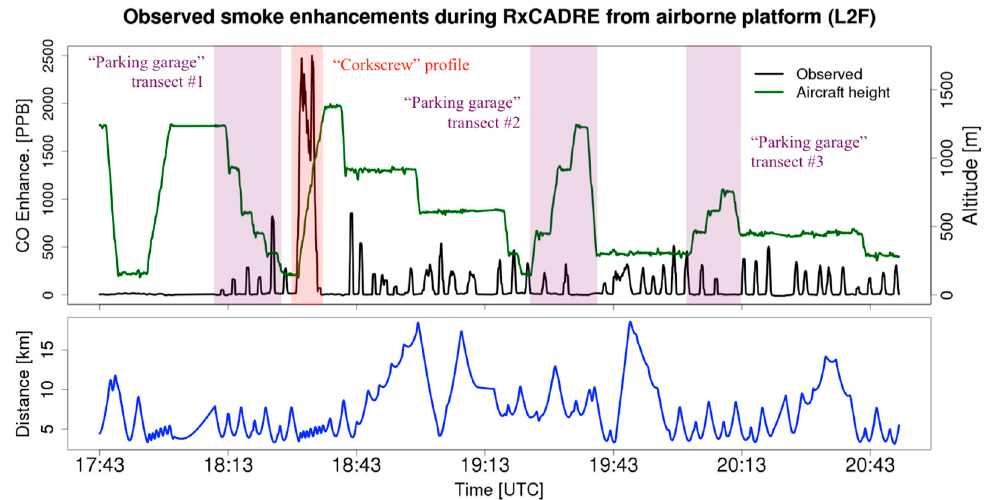
Figure 7. Aircraft measurements of CO enhancements above background during the L2F prescribed burn. Background concentrations were assumed to be ~110 ppb based on clean-air transects and were subtracted out. CO enhancements were smoothed using a 20-s centered moving average. The bottom panel indicates the aircraft distance from the middle of the L2F burn plot.